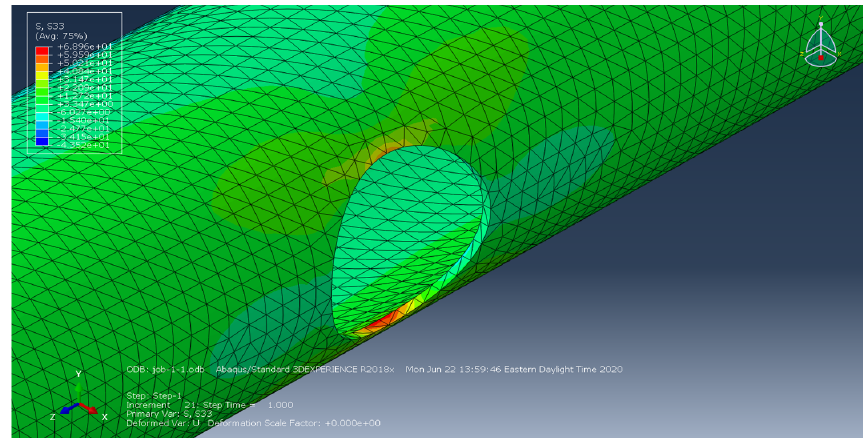
Figure 14. Aspect ratio 1-1 in longitudinal (Z) direction.